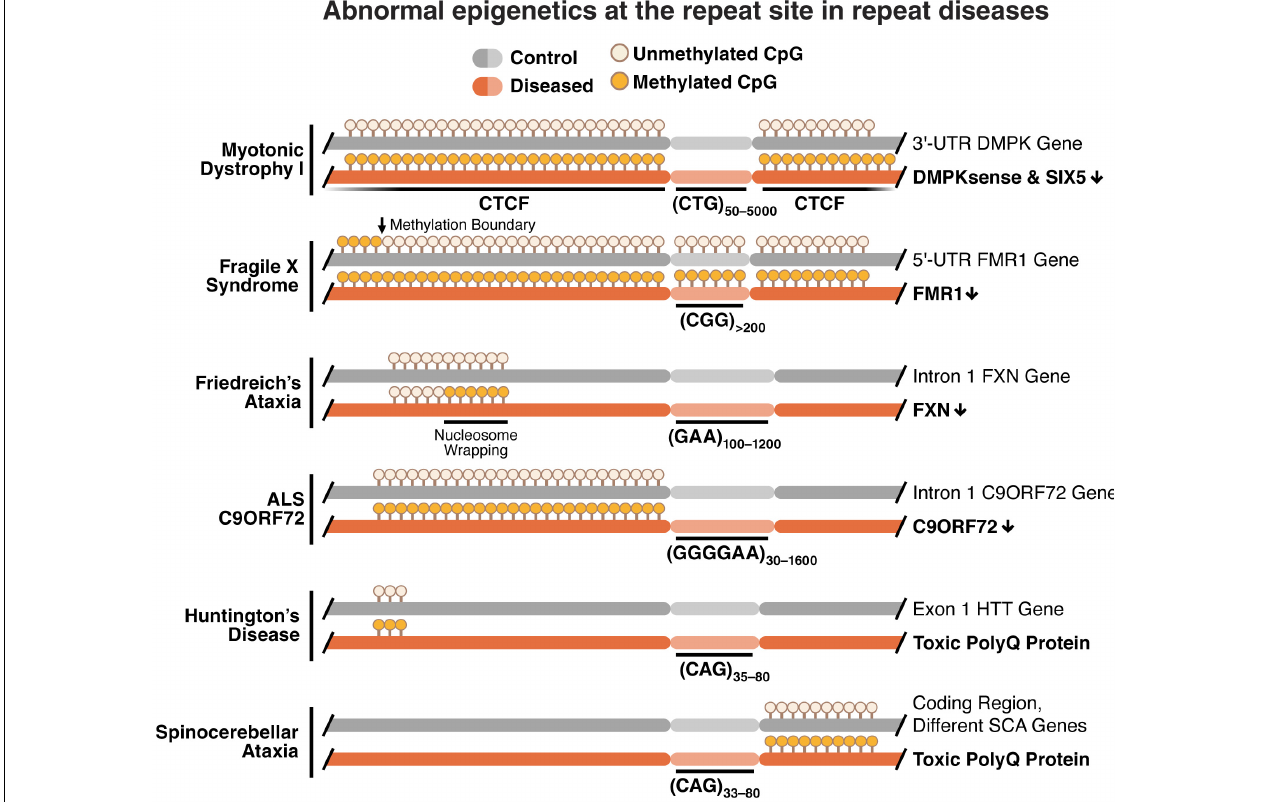
FIGURE 1 | Methylation of the repeat locus is associated with epigenetic deregulation of the nucleotide repeat region with a loss in CTCF binding, loss of TAD boundaries, chromatin condensation, and gene down regulation. Increased methylation is typically found near the repeat region in CG-rich areas called CpG islands. These differentially methylated regions include CTCF binding sites, and methylation inhibits binding of the CTCF protein. With a loss of CTCF binding, TAD boundaries are also lost and chromatin folding is altered to a more condensed formation. This leads to down regulation of genes with promoters and enhancers at or near the repeat region in several repeat